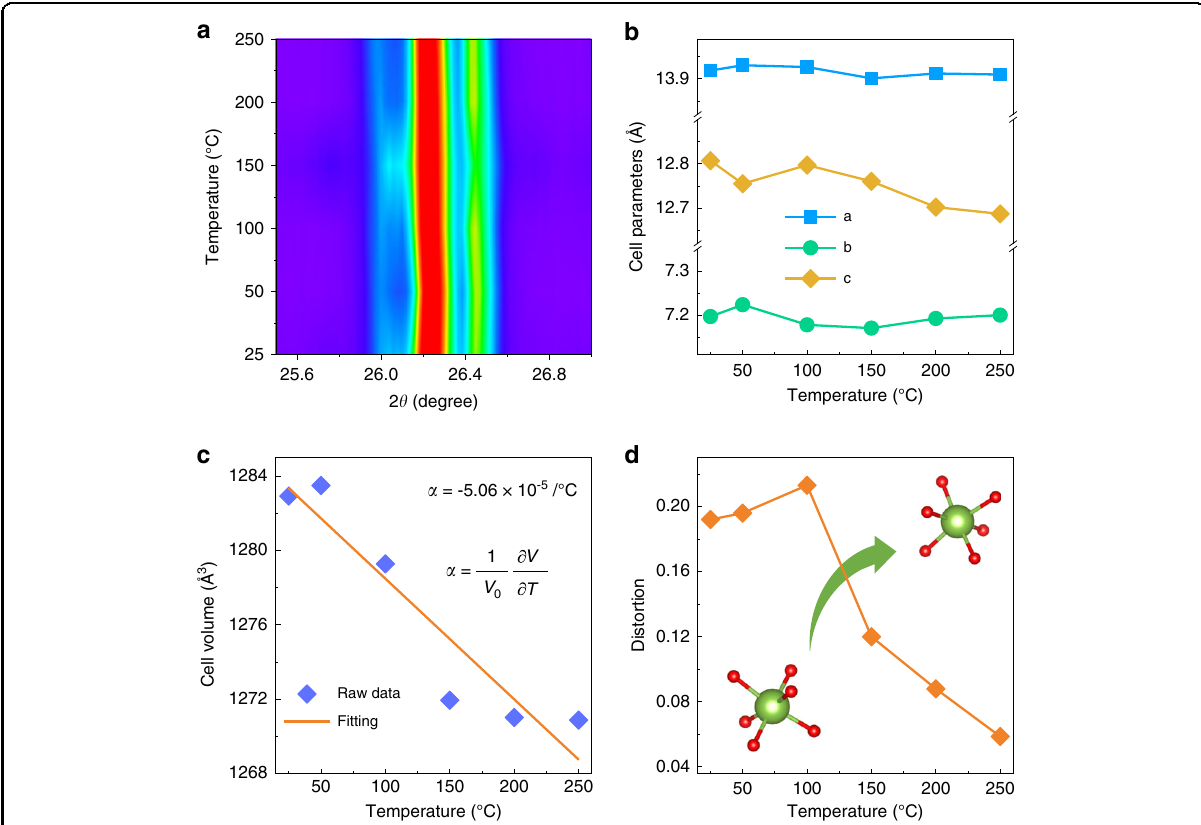
Fig. 5 Negative thermal expansion. a Enlarged XRD patterns (2 θ = 25.5 – 27°) of CEGO at different temperatures (25 – 250 °C). b The variation in cell parameters ( a – c ) for CEGO from 25 to 250 °C. c The linear fi tting of cell volumes over the temperature range from 25 to 250 °C. d The variation in the distortion of the EuO 6 octahedron with increasing temperature from 25 to 250